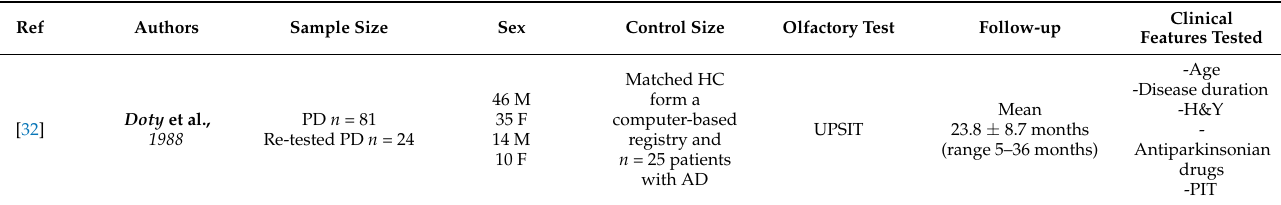
Table 1. Features of studies included in the